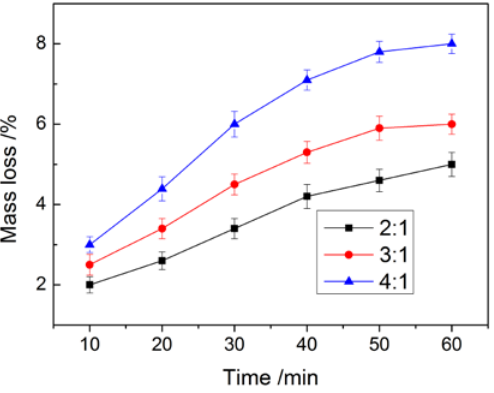
Figure 4. The influence of core/shell ratio on compactness of MicroPCMs.